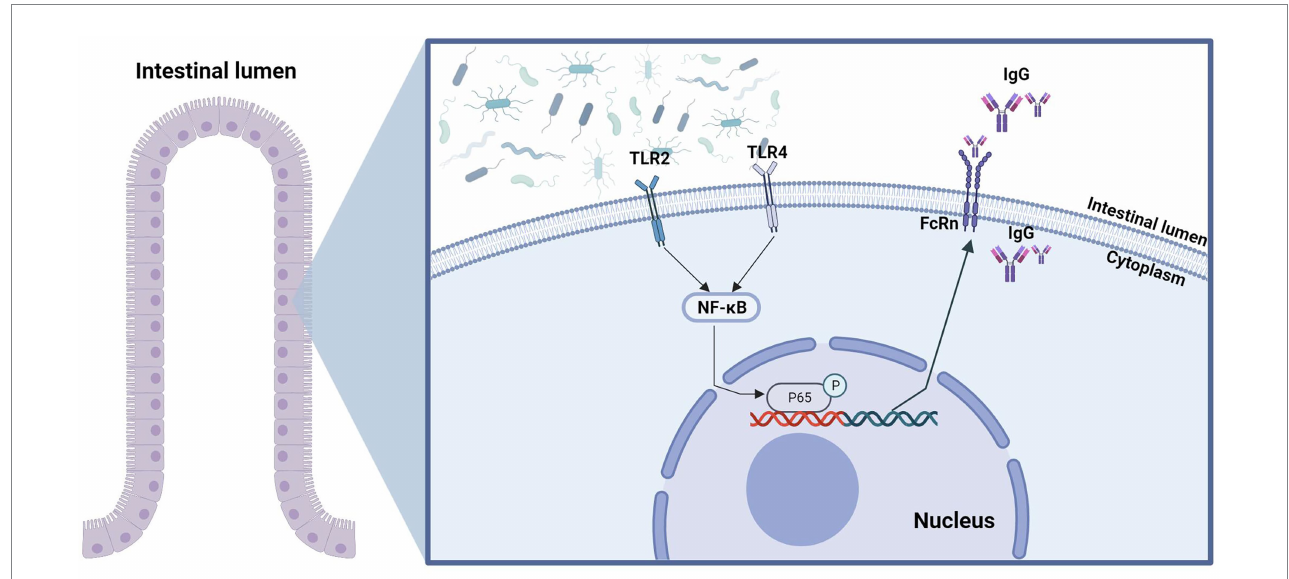
FIGURE 6 Schematic summary of the findings in this